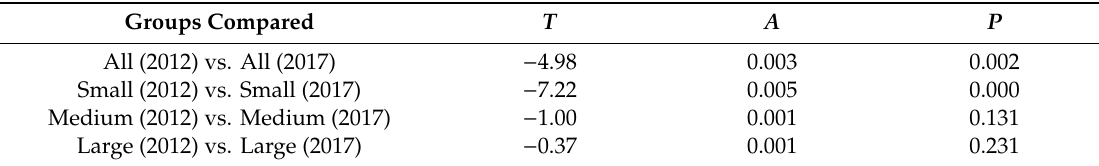
Table 3. Multi-response permutation procedures (MRPP) to test for significance of variation in species composition of di ff erent DBH classes during forest succession. The DBH classes are as follows: All, All